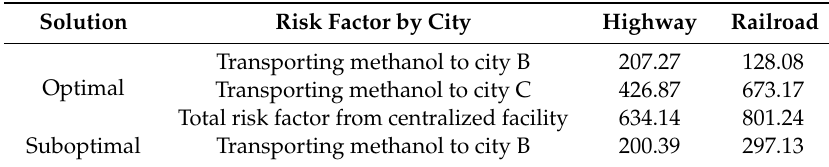
Table 5. Risk results for methanol transportation.